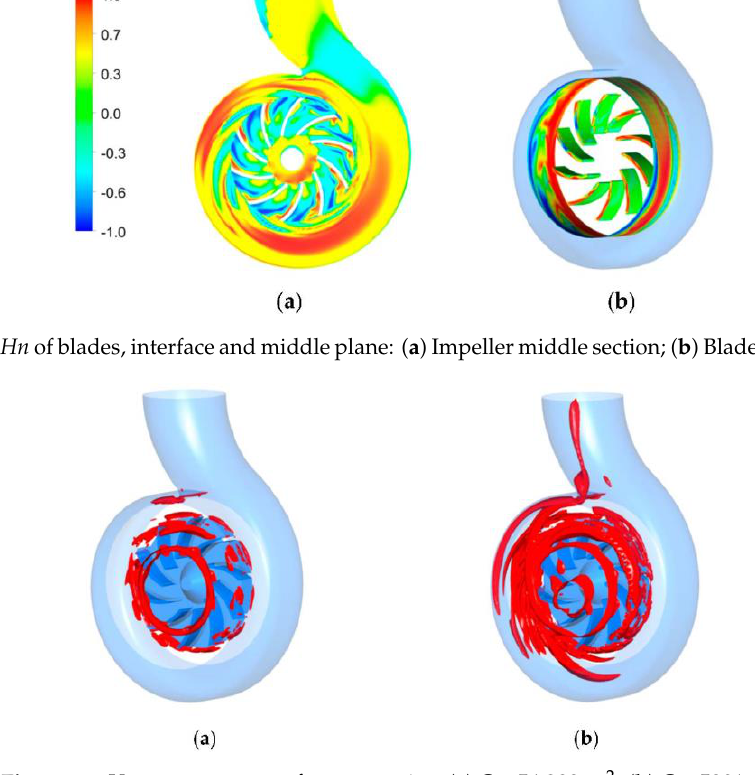
Figure 12. Vortex structures of pump cavity: ( a ) Q =54,288 s −2 ; ( b ) Q =5301 s −2 .